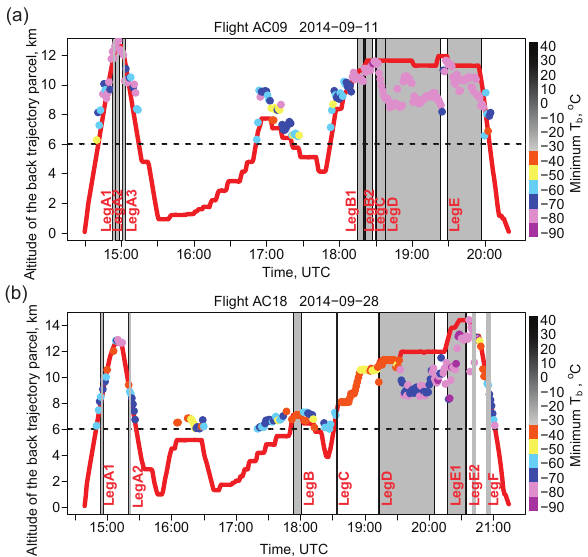
Figure 19. Air mass contacts with deep convection. The colors indi- cate the cloud top temperature of the convective system with which the trajectory had the most recent contact. The aircraft altitude at which the air mass was sampled is indicated by the red line. The col- ored dots are plotted at the altitude at which the air mass crossed the grid cell with the convective system. The dots are only plotted if this altitude is greater than 6km and if it encountered a DC region (i.e., T b < − 30 ◦ C). The shaded areas correspond to the flight segments with elevated CN concentrations. (a) Flight AC09, (b) flight AC18. Figure 20. (a) Number of hours since last contact with deep convec-